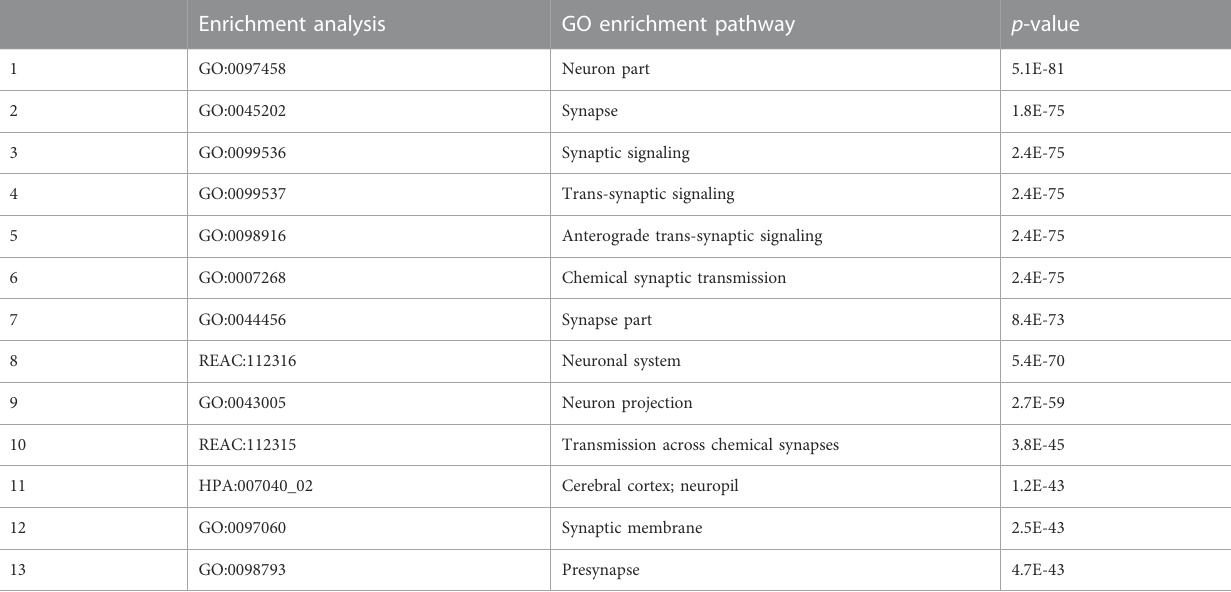
TABLE 2 Results of GO, REAC, and HPA enrichment analyses.